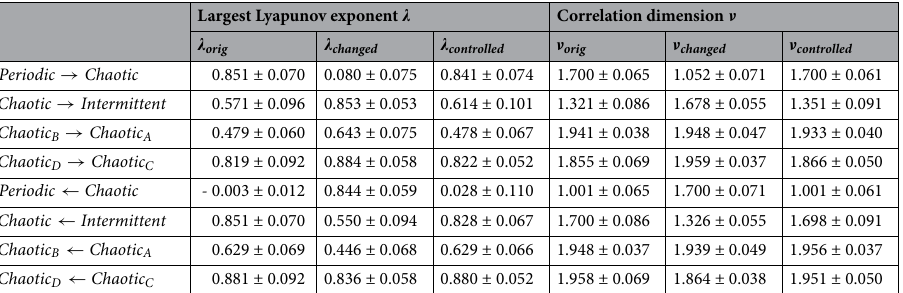
Table 1. Statistical simulation over N = 100 random realizations of the systems evaluated in terms of the mean values of the largest Lyapunov exponent and the correlation dimension with corresponding standard deviations. The subscript orig denotes the initial state of the system, while changed refers to the new state after parameters changed and controlled means the system controlled back into the original state. The description left to the arrow is the original state that also will be achieved again after controlling the system whereas the state written right to the arrow corresponds to the changed condition.